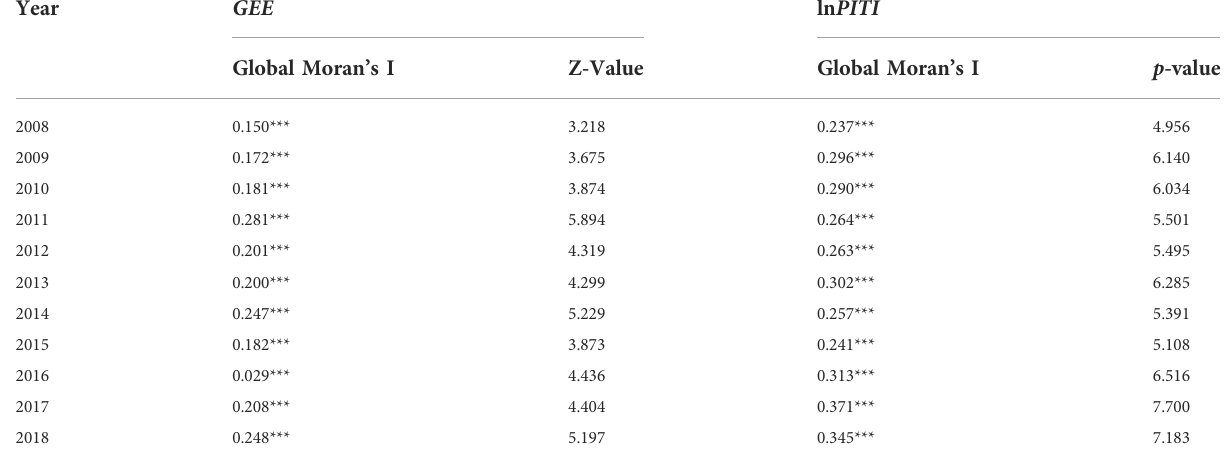
TABLE 3 Results of global morans ’